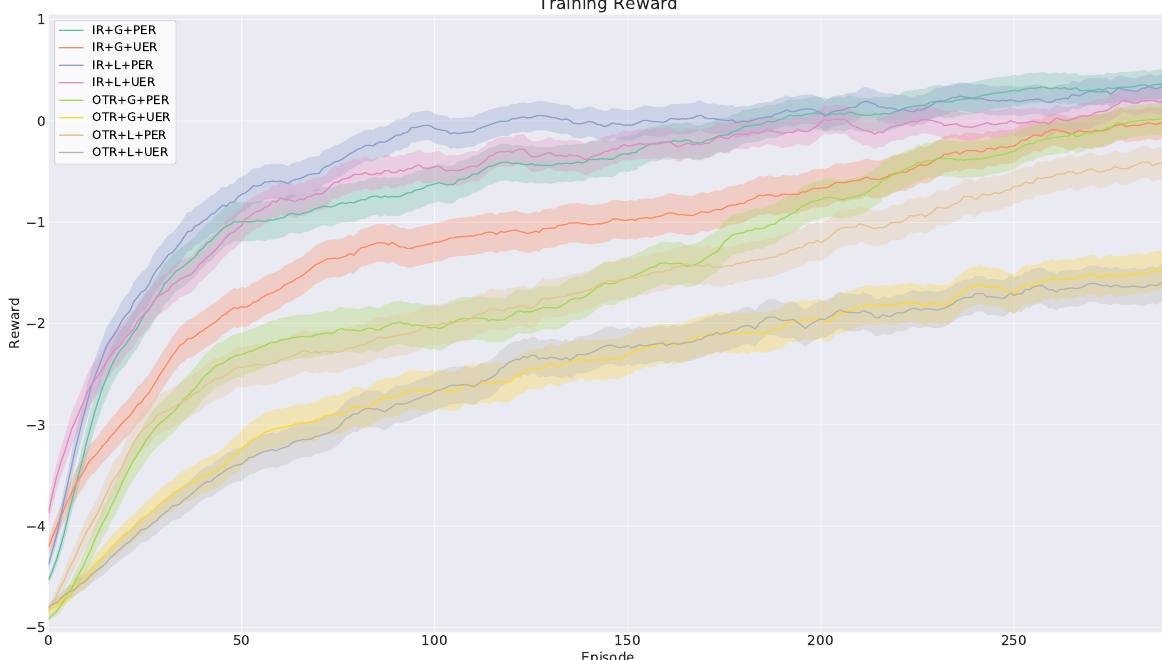
Figure 6: The collected reward in each episode during training. The graphs include only the first 300 episodes. The RL agents learn faster when they receive the intermediate reward. Moreover, prioritized experience replay outperforms the uniform experience replay. The curves are smoothed with a moving average with a sliding window of 10 episodes. The confidence interval shows the standard error and each curve is the average of 160 experiments (16 RL agents × 10 trials).